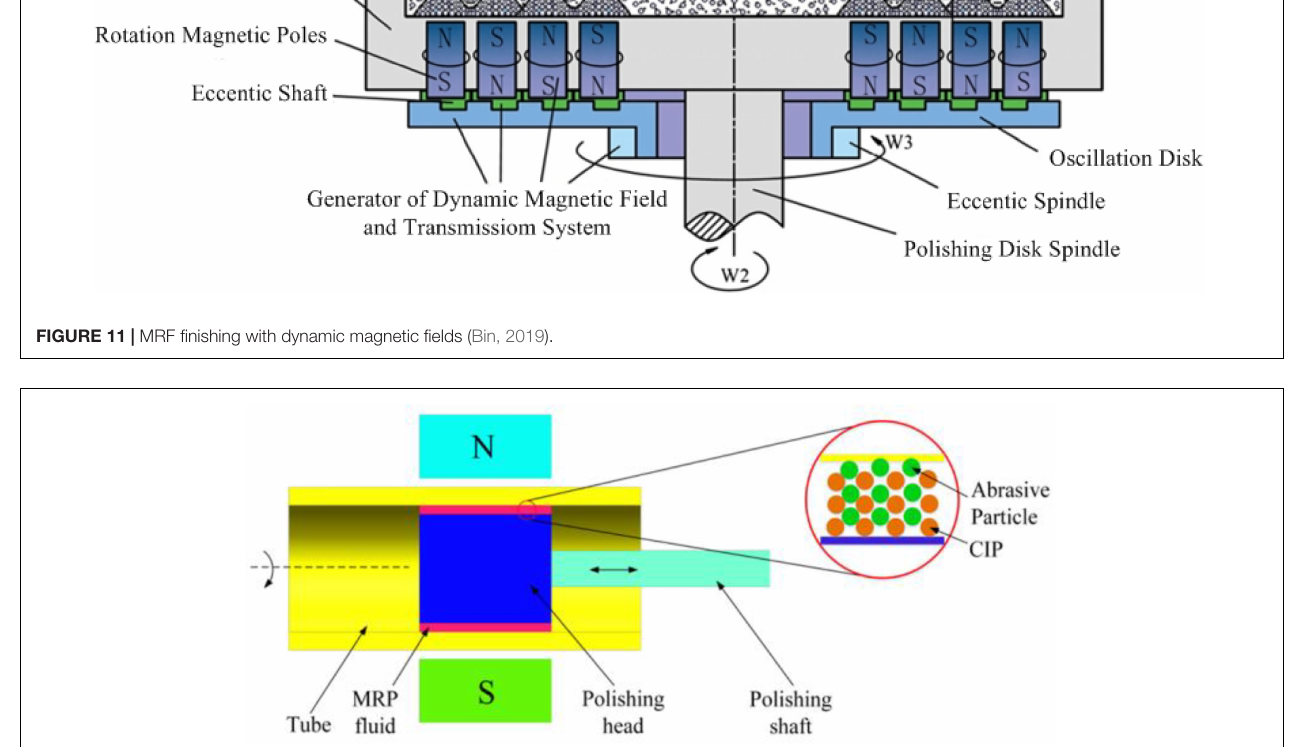
FIGURE 12 | Schematic diagram of novel polishing principle (Ghosh et al., 2021).